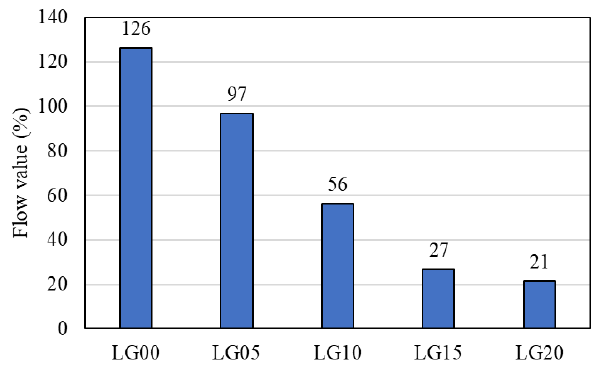
Figure 5. Flow values of geopolymer mortar containing BLWA .